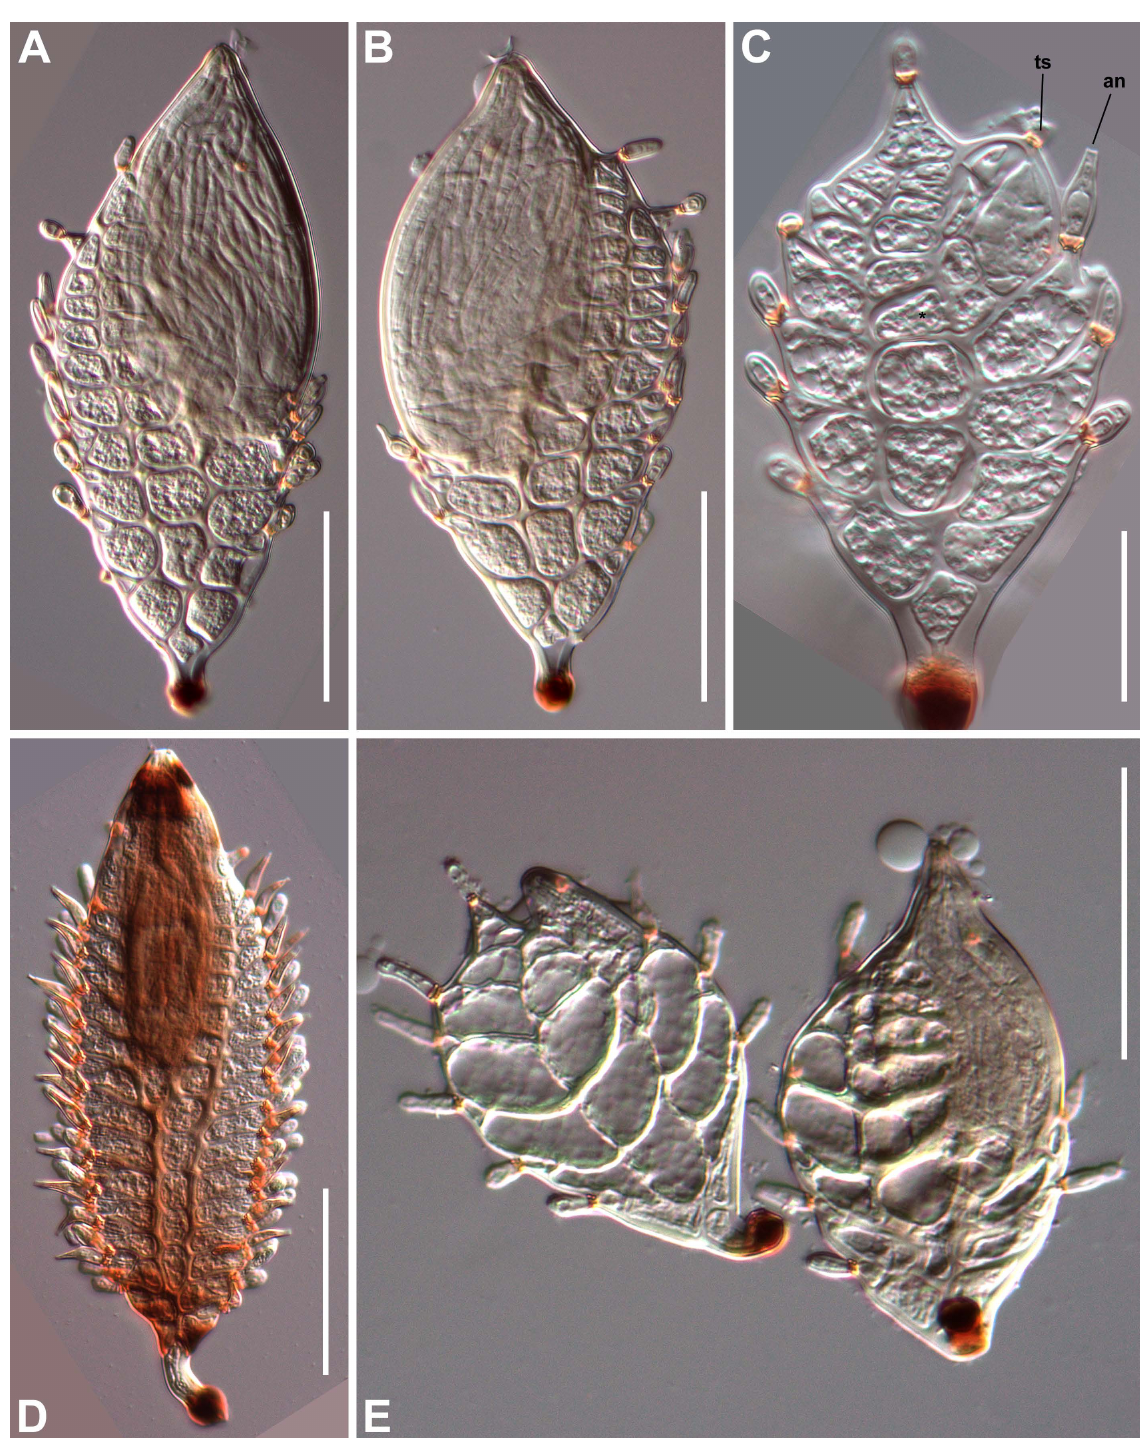
Fig. 70. Rickia spp. A – C . R. huggertii Balazuc. A – B . Mature thalli. C . Immature thallus showing the trichogyne scar (ts) and the antheridium (an). – D . R. peyerimhoffii Maire. Mature thallus . – E . R. proteini T.Majewski. Immature thallus at left and mature thallus on the right. Scale bars: A–B, D–E = 50 µm; C = 20 µm. Photographs from slides ZMUC C-F-122781 (A–B), ZMUC C-F-122862 (C), ZMUC C-F- 122656 (D), ZMUC C-F-122485